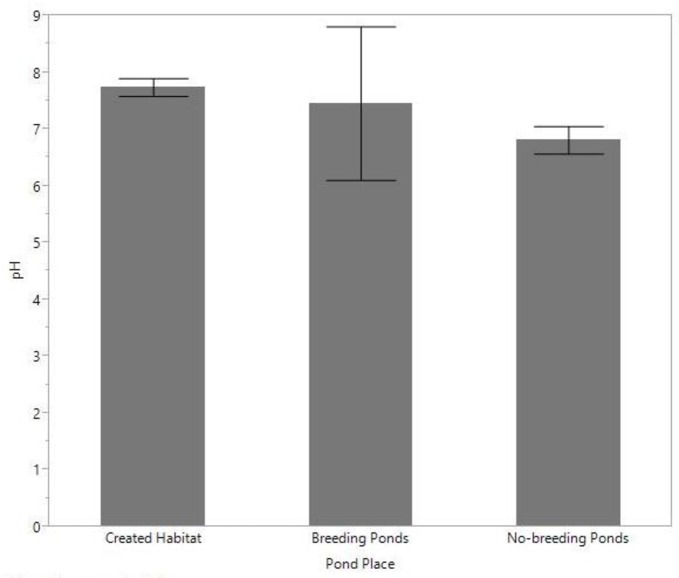
Mean pond pH levels across each of the pond places.Error bars represent 95% confidence intervals.